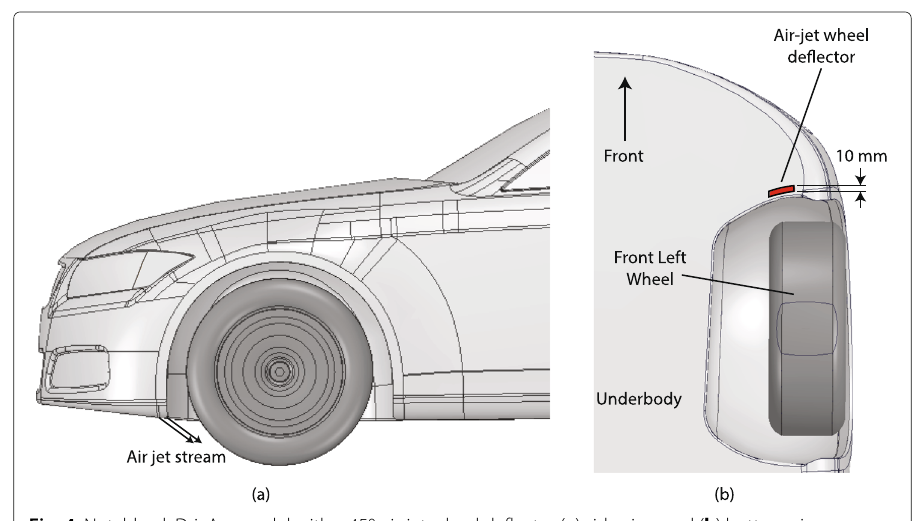
Fig. 4 Notchback DrivAer model with a 45 ◦ air-jet wheel deflector ( a ) side view and ( b ) bottom